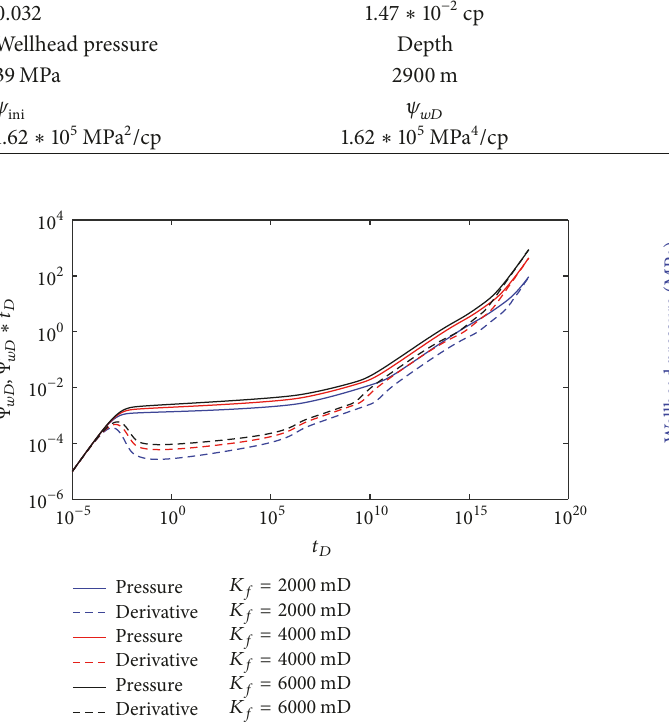
Figure 13: Effect of induced fracture permeability on pressure.